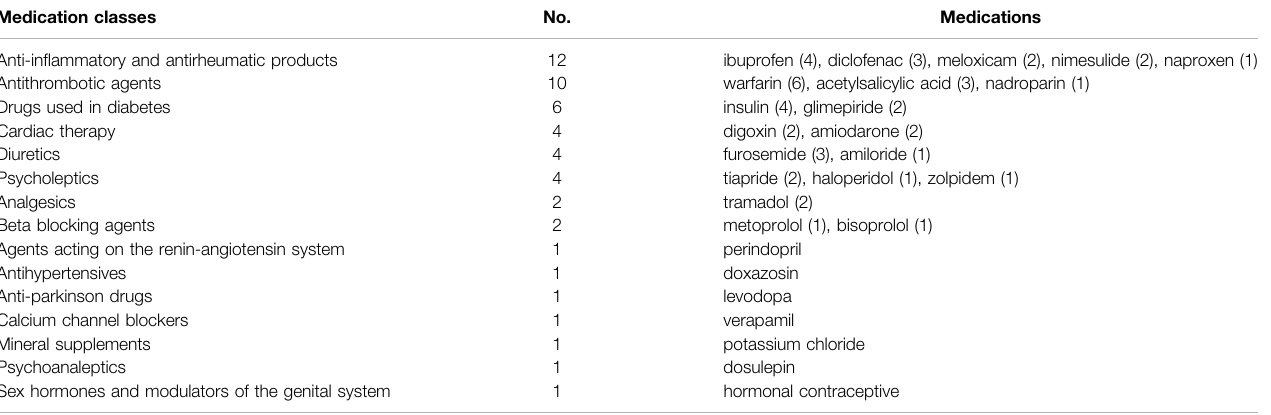
TABLE 12 | Medication classes involved in potentially preventable DRAs related to treatment safety (N = 51). Medication classes